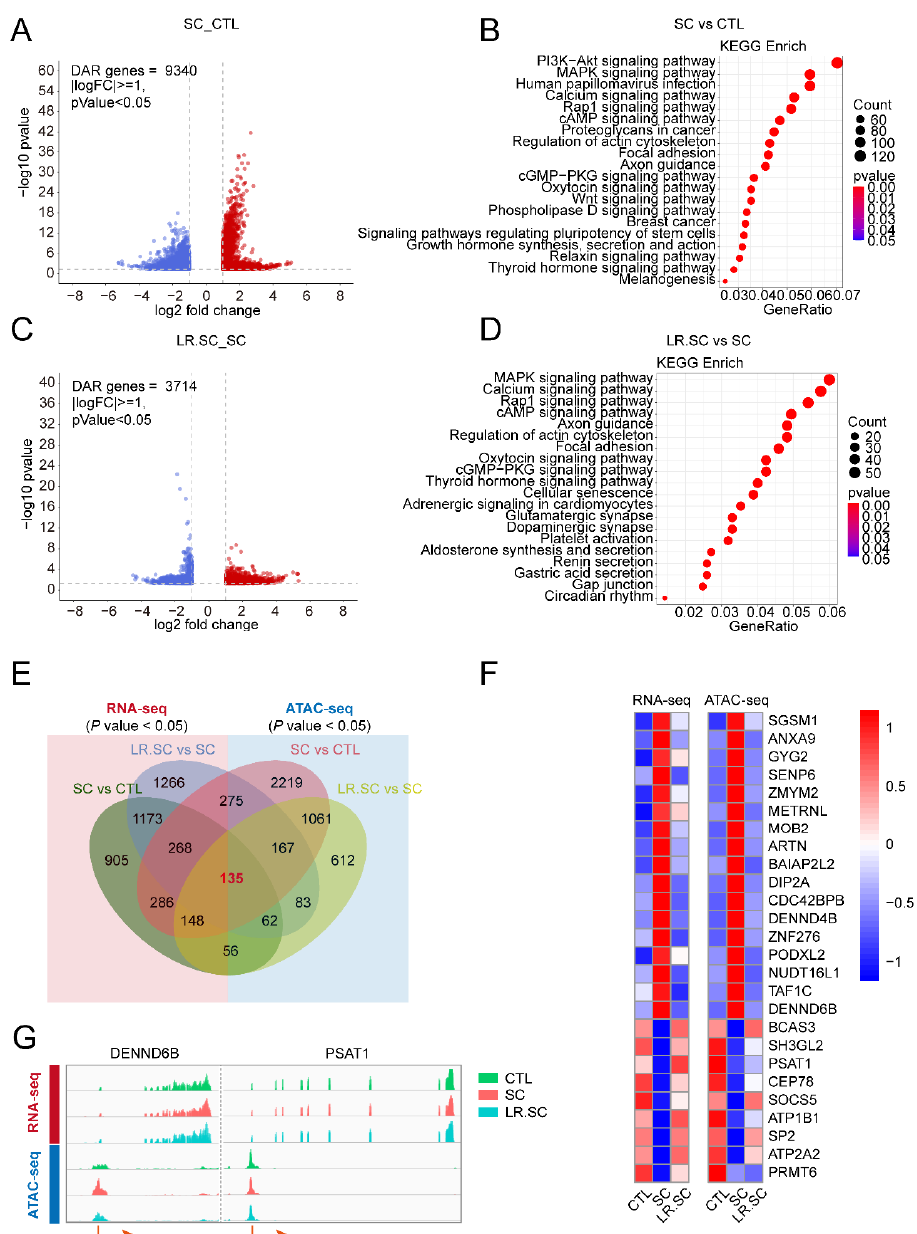
Figure 4. Genome-wide changes in chromatin accessibility induced by S. enterica BNCC186354 and L. reuteri ATCC 53608. ( A , B ). Volcano plot and top 20 signaling pathways of DEGs between S. enterica BNCC186354 and control groups. ( C , D ). Volcano plot and top 20 signaling pathways of DEGs between S. enterica BNCC186354 groups with and without L. reuteri ATCC 53,608 treatment. The threshold was set as a fold-change ≥ 1 and adjusted p -value < 0.05. ( E ). Venn diagram shows common DEGs and genes annotated by DARs between RNA-seq and ATAC-seq with a p -value < 0.05. The red background represents RNA-seq and the blue background represents ATAC-seq; the numbers marked in red represent the genes jointly screened among different comparison groups in ATAC-seq and RNA-seq data. ( F ). Heatmap of 26 genes with similar trends between gene expression and chromatin accessibility. ( G ) IGV was used to visualize expression and chromatin accessibility of DENND6B and PSAT1 genes.